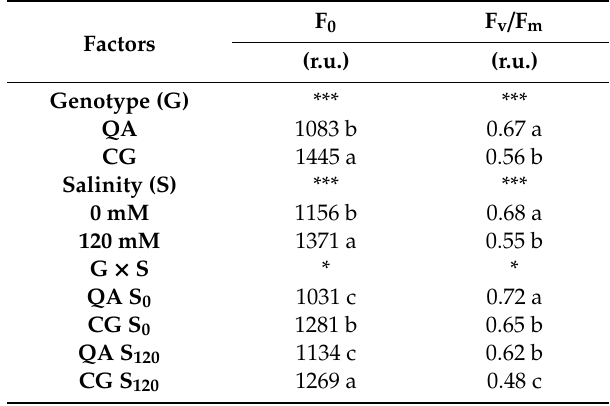
p < 0.05, p < 0.01 and p < 0.001, respectively. In each column, for each factor, means with the same letter